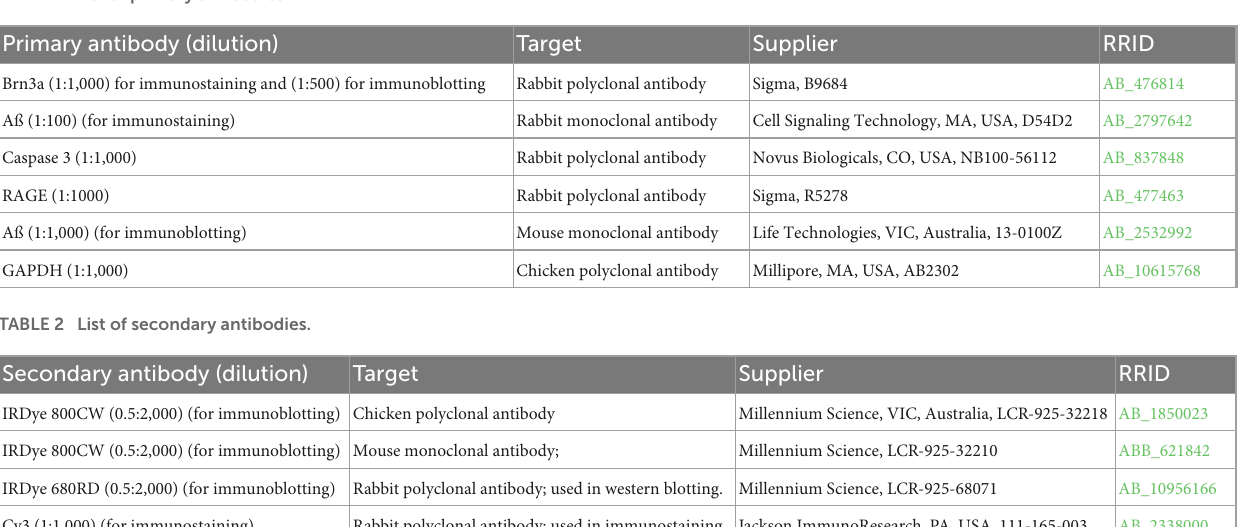
TABLE 1 List of primary antibodies.